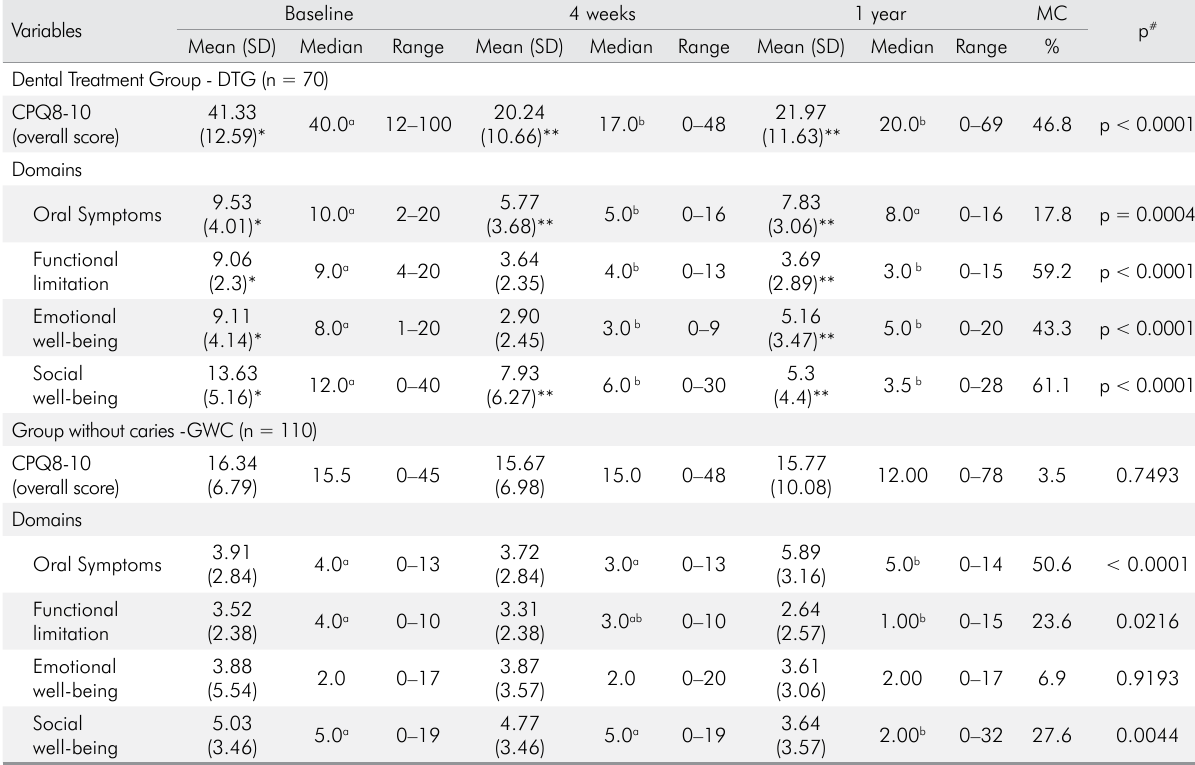
Table. Mean, standard deviation, median and range of all domains and in overall CPQ at 1